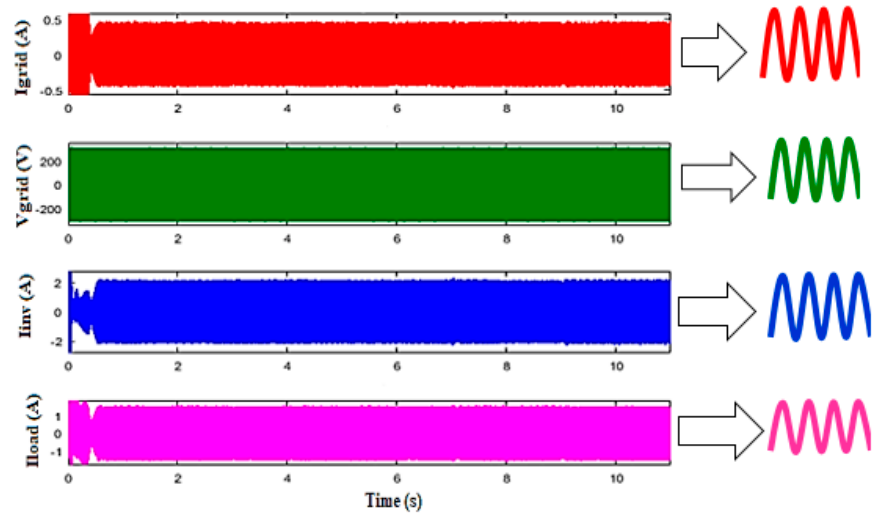
Figure 15. The profile of alternating voltages–currents. The results show that the sum of the absorbed current by the AC load and the current injected into the grid is effectively equal to the current provided by the hybrid power system. The synchronization of the voltage and current injected to the grid is detailed in Figure 16.